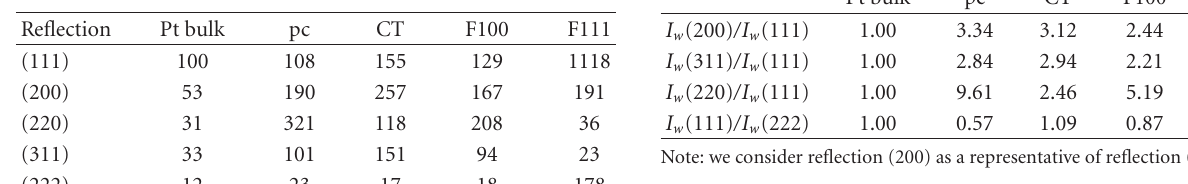
Table 1: Integrated intensities for pc Pt, CT Pt, Pt F100, and Pt F111 electrodes. The intensities are expressed as intensity ∗ Δ (2 θ ) = counts ∗ degree.